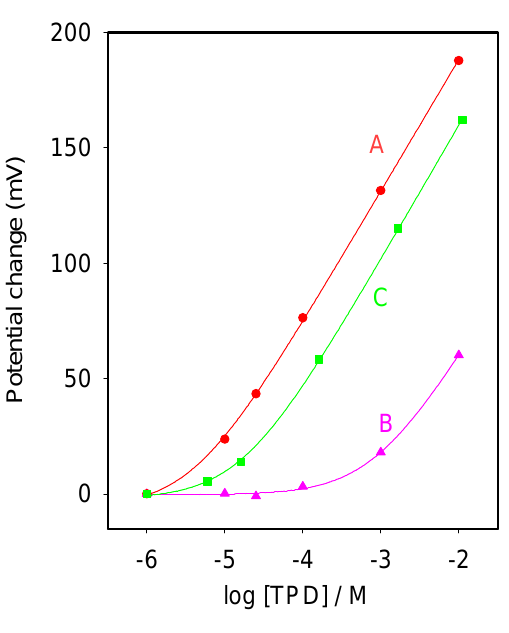
Figure 1: Calibration graphs for membranes A, B and